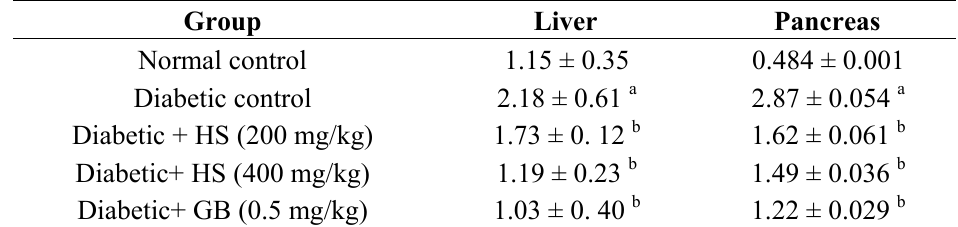
Table 2. Changes in the contents of TBA-reactive substance in liver and pancreas in diabetic rats treated with